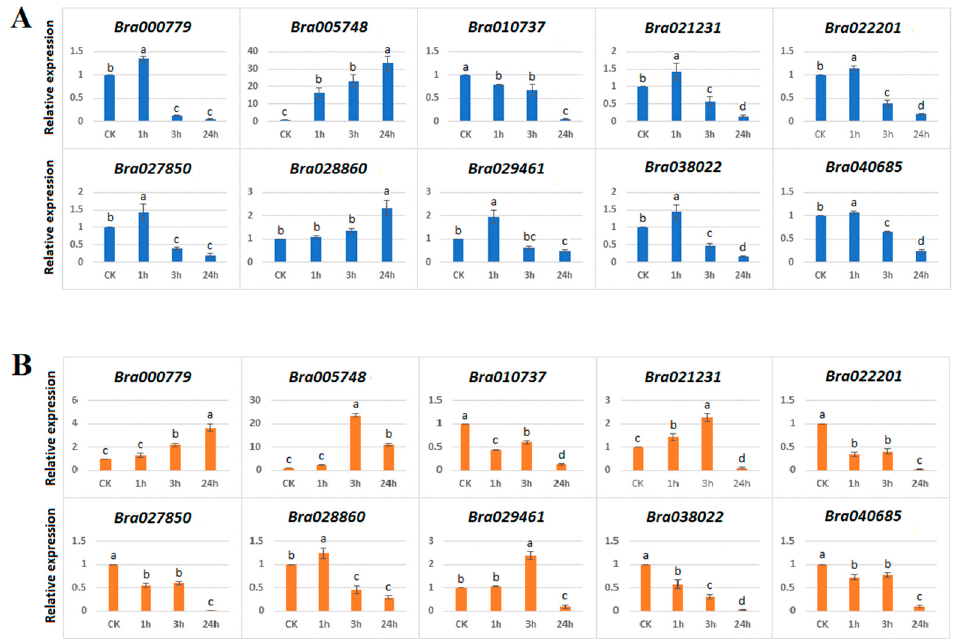
Figure 7. qRT-PCR expression patterns of 10 B. rapa HECT genes under salt ( A ) and drought ( B ) treatments. The sampling time-points are on the x -axis and the relative expression levels are on the y -axis. Statistical significance of differences between control and treated groups was analyzed using Tukey tests. The different letters indicate the statistically significant differences with p ≤ 0.05.